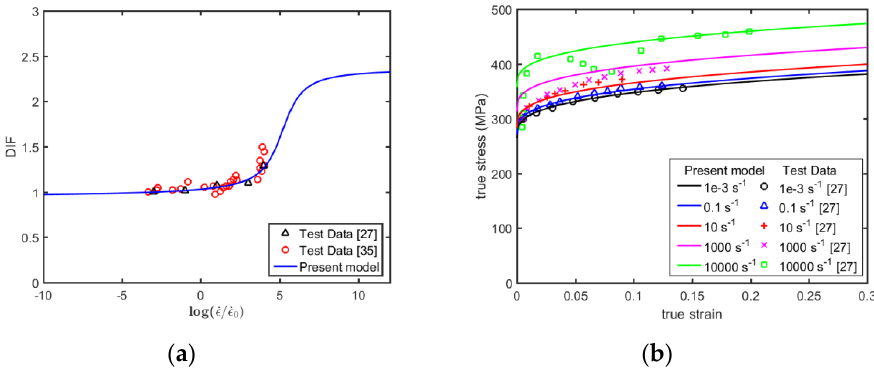
Figure 3. Comparison of the present model with the test data for 6061-T6 aluminum alloy. ( a ) DIF versus strain rate at a plastic strain corresponding to the ultimate tensile strength (UTS) in tension tests at room temperature; and ( b ) true tress-true strain curves in tension.